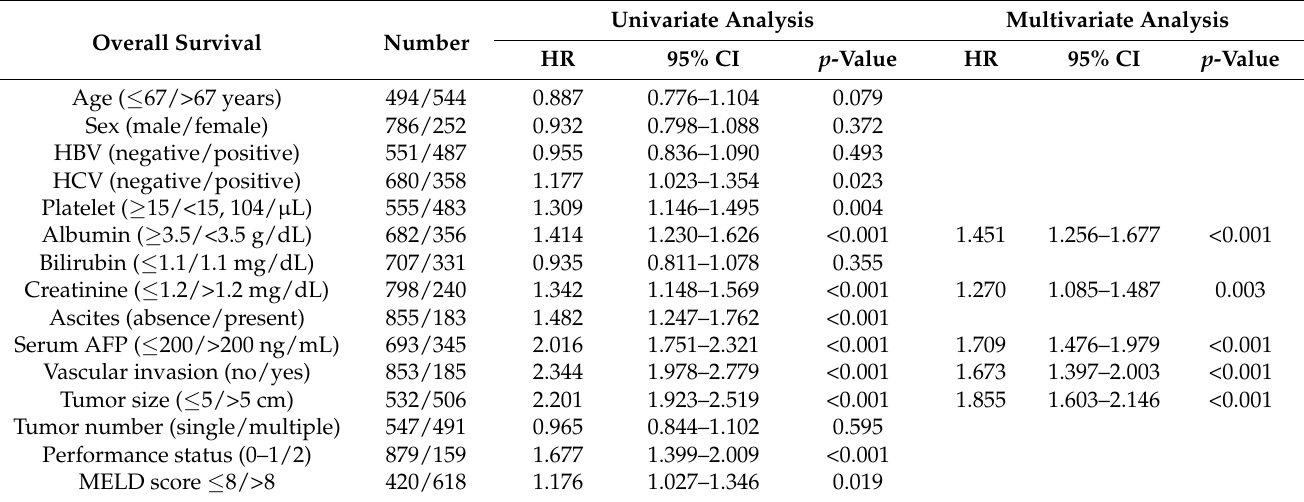
Table 7. Multivariate analysis of overall survival in patients undergoing transarterial chemoemboliza- tion including MELD score.